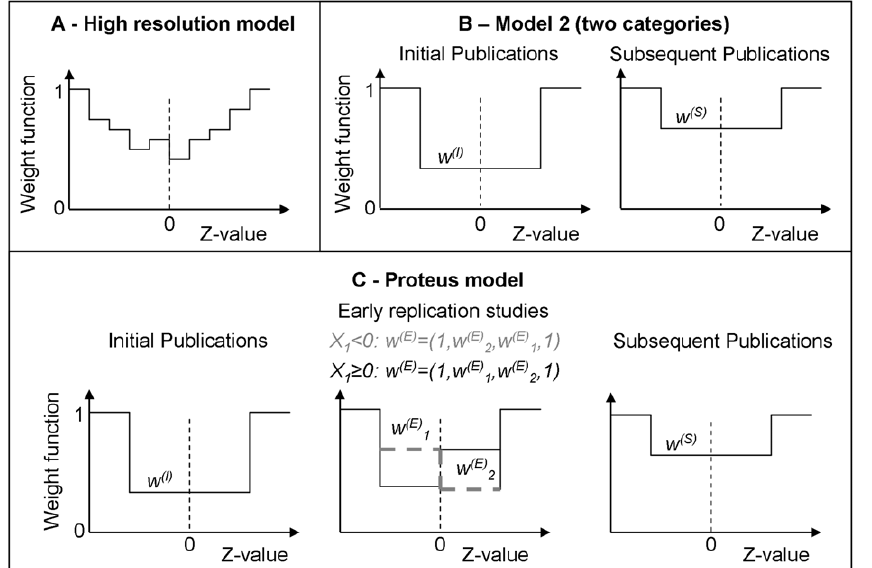
Figure 1. Weight functions for the publication bias models. The models specify the probability of a result to be published depending on the Z-value associated with the outcome. Weights are assumed to be stepwise constant, and are relative to the outer intervals where the weight function is set to one. ( A ) High resolution model. Using a stepwise constant weight function with many intervals allows studying the shape of publication bias. In our model we use 16 intervals. Model 1 is a simplified version with only three intervals, and a single free weight function parameter. ( B ) Model 2 (two categories). The weight function is assumed to differ for initial and subsequent studies. Initial studies with Z-values that fall into the mid interval are subject to weight w (I) , subsequent ones are subject to weight w (S) . Model 1 (see Methods), in contrast, uses a single one-parameter weight function that applies to all studies. ( C ) Proteus model. The weight functions are assumed to differ for initial studies, early replications, and subsequent publications. The shape for early replications depends on the result of the initial study (solid black line: initial result with z # 0 , dashed grey line: initial result with z . 0 ). This allows investigating whether early replication studies are more likely published if they oppose initial results. Model 3, described in detail in the Methods section, matches the Proteus model in complexity, but does not take into account that the sign of the initial study might have an impact on the weight function for early replications.